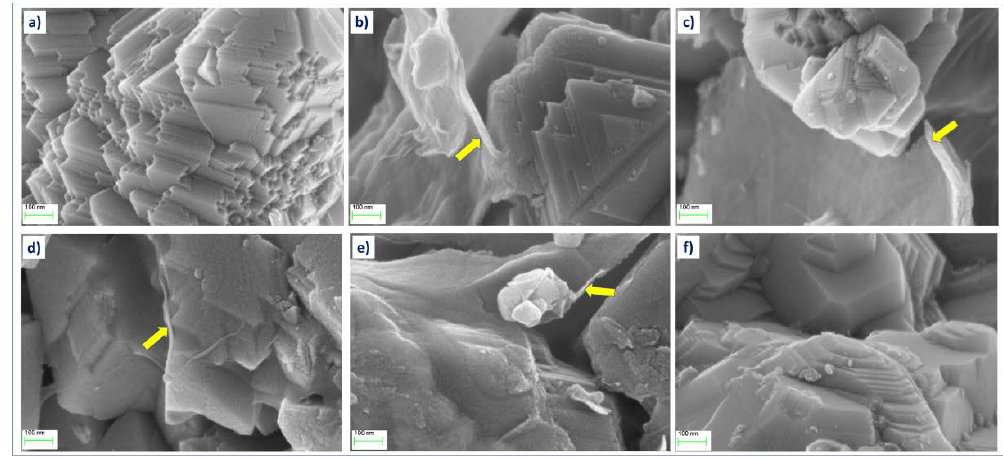
Figure 3. SEM images of ( a ) LMO powder with a various content of GO: ( b ) 1%wt., ( c ) 2%wt., ( d ) 3%wt., ( e ) 4%wt., ( f ) and 5%wt.